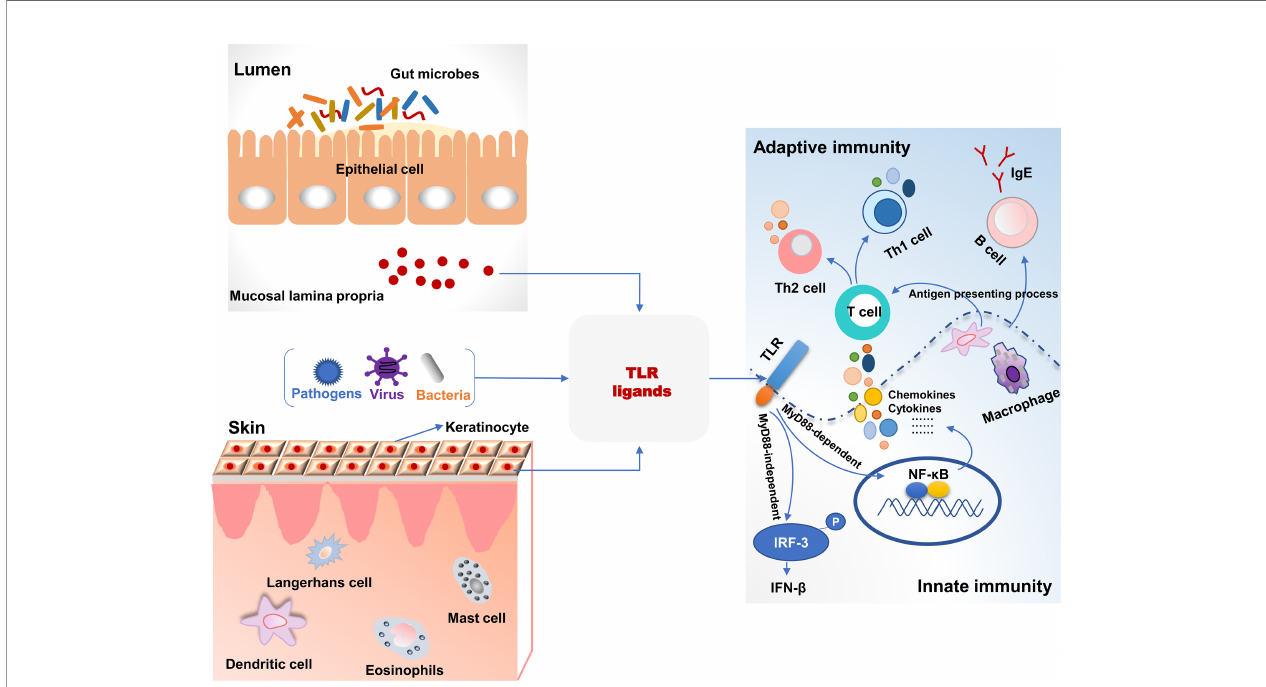
FIGURE 1 | The association of toll-like receptor signaling and immune responses in the intestine and skin. TLR ligands from bacteria, viruses, and pathogens were recognized and activated TLR signaling pathways, which bridged the innate and adaptive immunity in the intestine and skin. TLR, toll-like receptors; MyD88, myeloid differentiation factor 88; P,